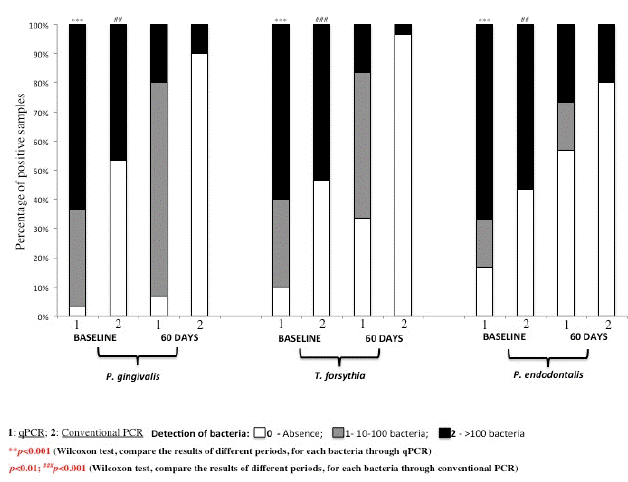
Fig.1. Bacteria detection (%) through qPCR and conventional